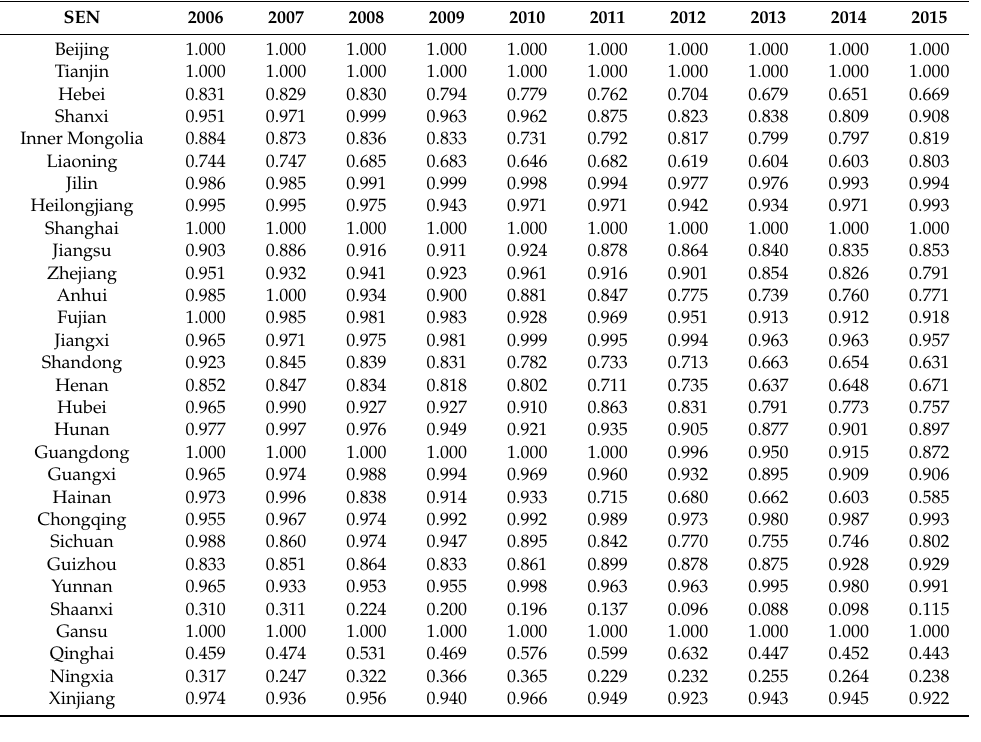
Table 4. Scale e ffi ciency under natural disposability from 2006 to 2015.